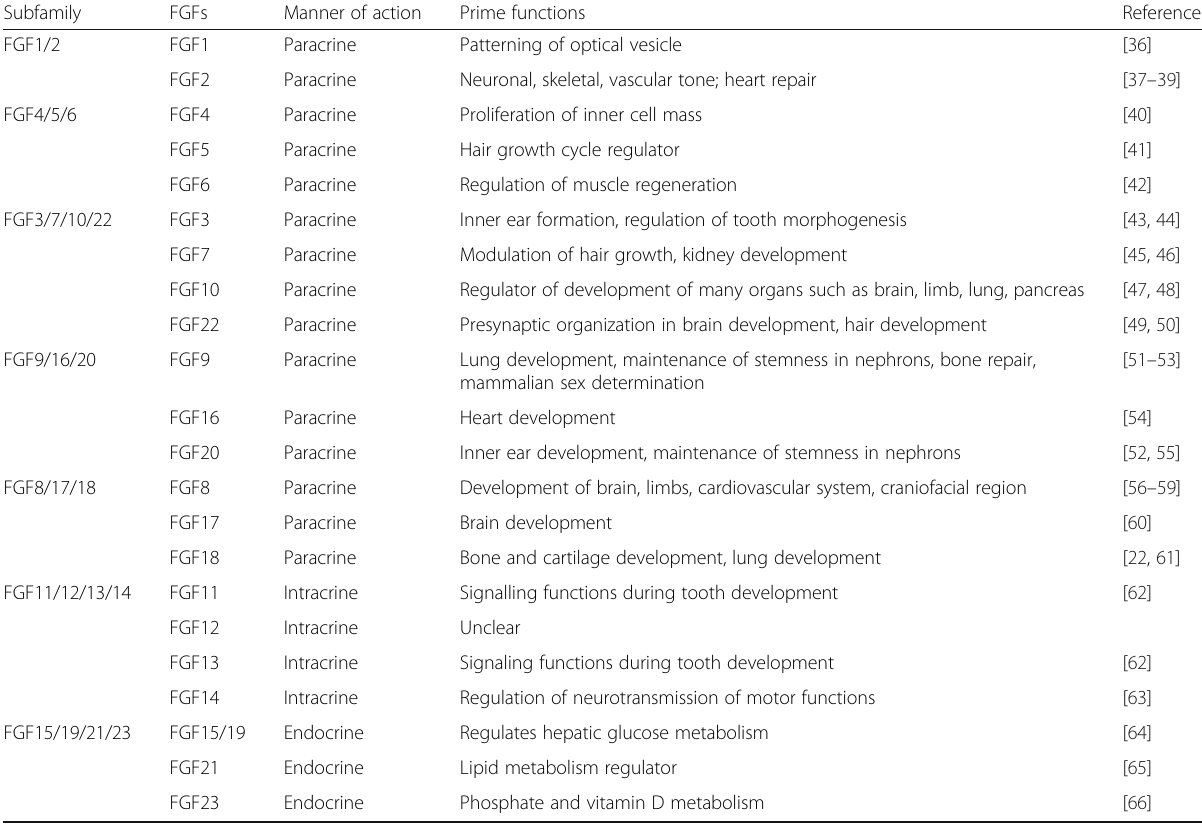
Table 1 List of FGFs and their various functions Subfamily FGFs Manner of action Prime functions